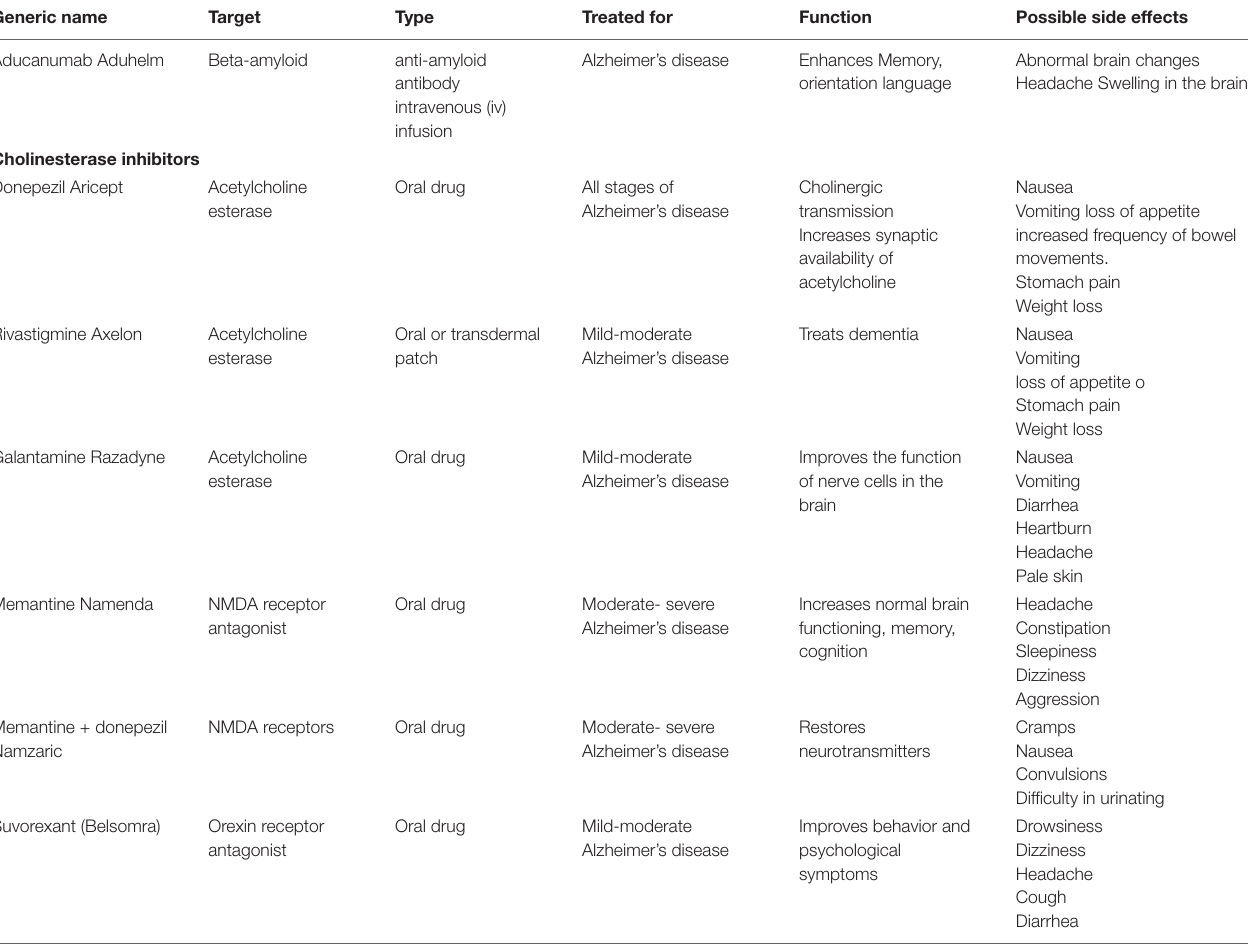
TABLE 1 | FDA approved drugs in the treatment of Alzheimer’s